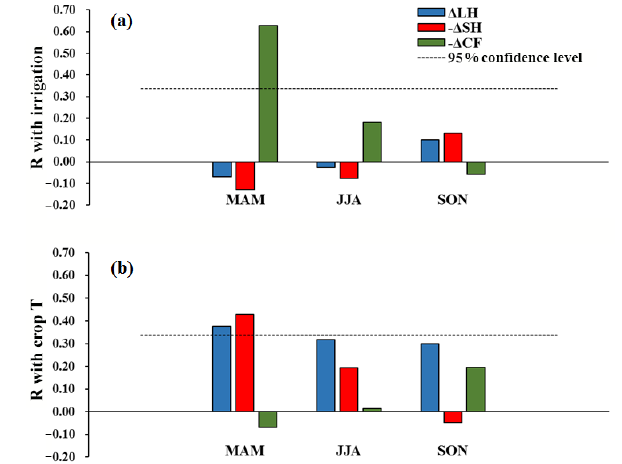
Figure 12. (a) Temporal correlation coefficients between the irriga- tion rate and (cid:49) LH, − (cid:49) SH, and − (cid:49) NEE over spring, summer, and autumn and (b) temporal correlation coefficients between the crop temperature and (cid:49) LH, − (cid:49) SH, and − (cid:49) NEE over spring, summer, and